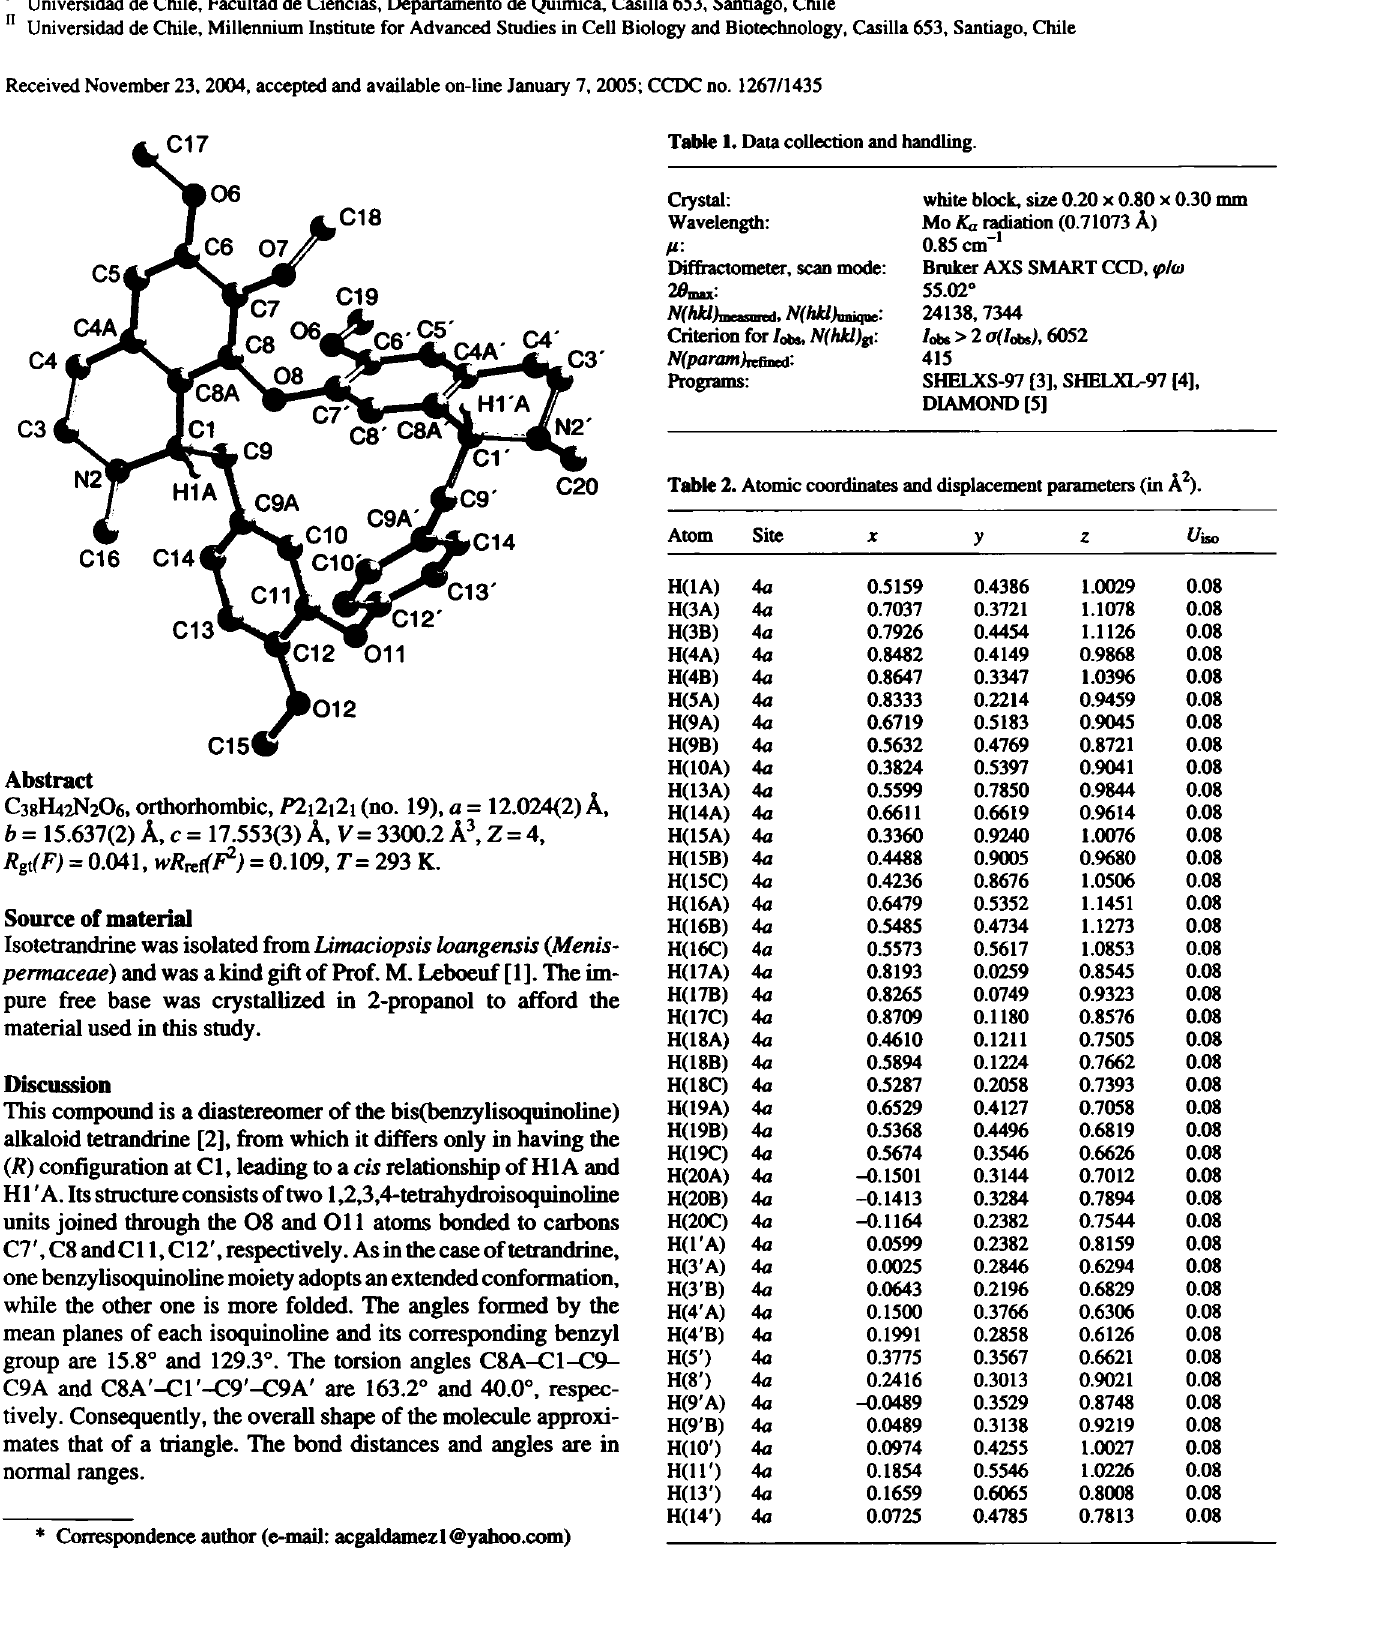
Table 1. Data collection and handling.